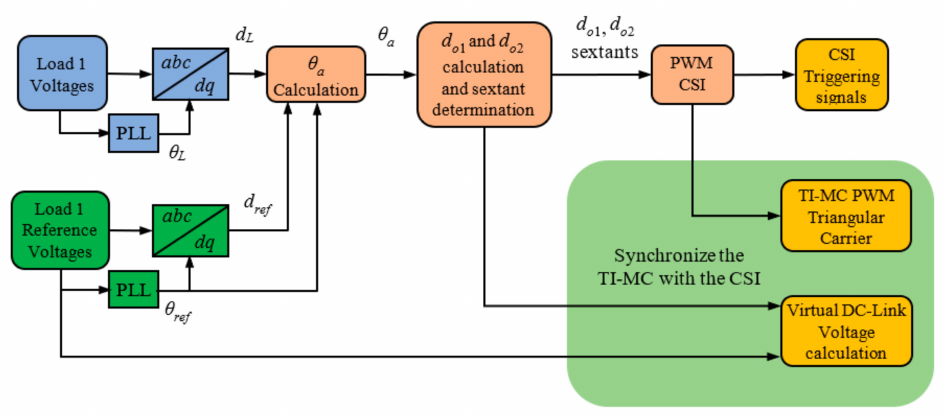
Figure 6. CSI control